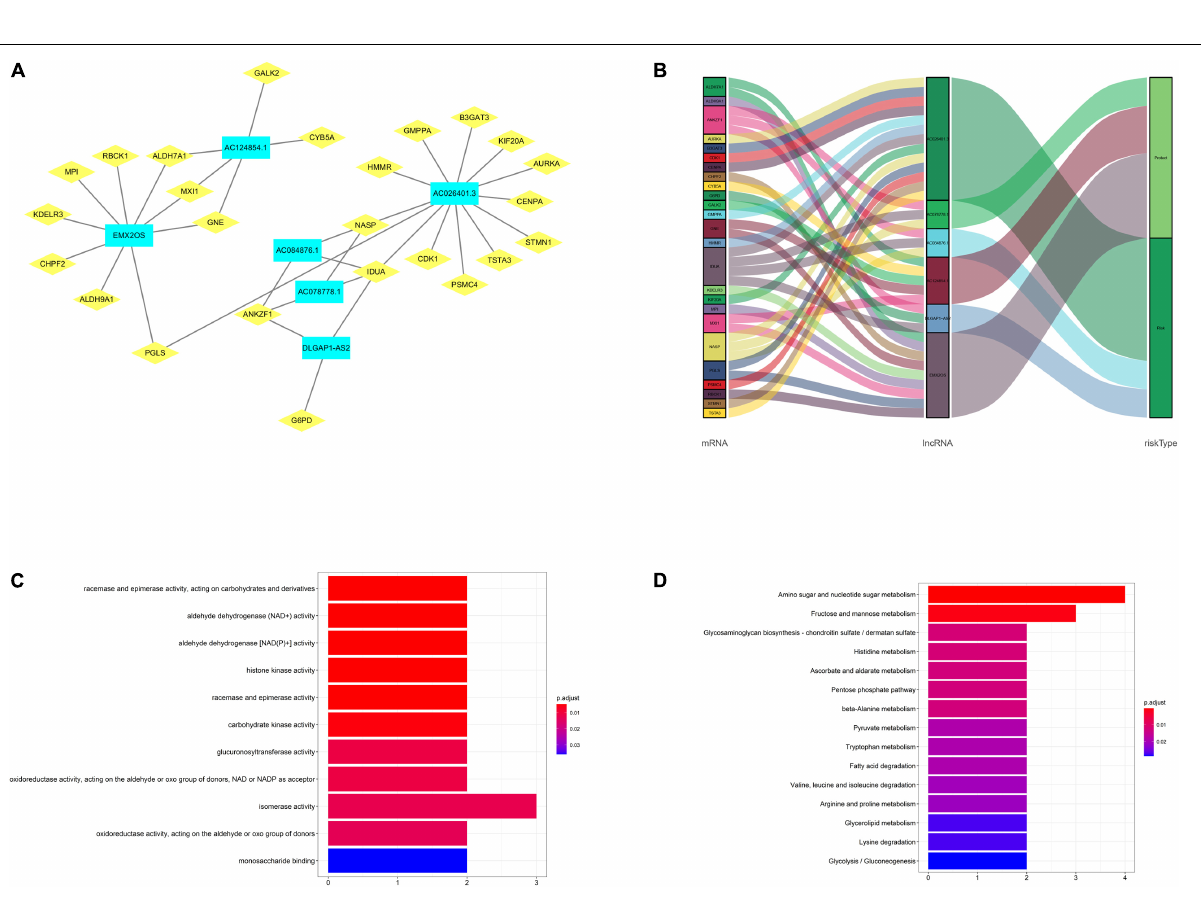
FIGURE 7 | Construction and analysis of the lncRNA-mRNA co-expression network. (A) The diagram shows 36 lncRNA-mRNA links among 6 lncRNAs and 25 related mRNAs. (B) The Sankey diagram exhibited the correlation between the 25 mRNAs and 6 lncRNAs (risk/protective). (C) The GO term shows the enriched molecular biological metabolic processes. (D) The KEGG pathway analysis shows the significantly enriched